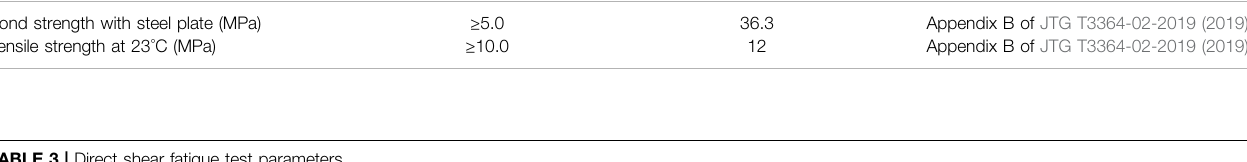
TABLE 3 | Direct shear fatigue test